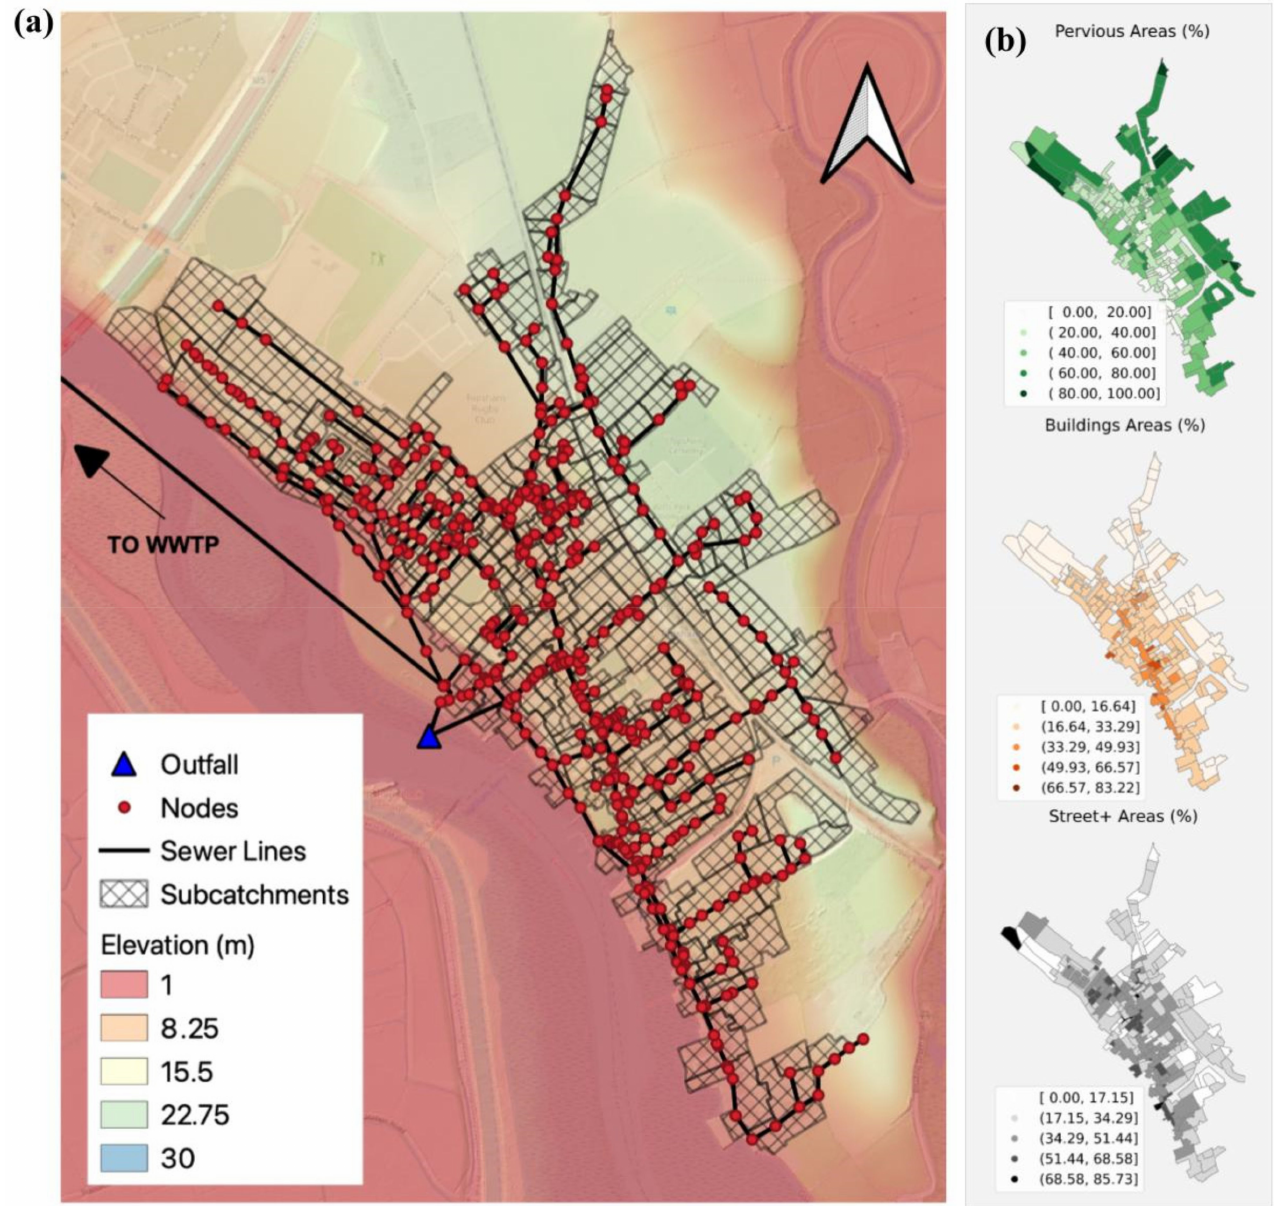
Figure 4. ( a ) Overview of the sewer network in the case study. Elevation data were obtained from [42]. ( b ) Land use categories of the case study. Streets+ refers to streets, paths and parking areas. The data used were obtained from